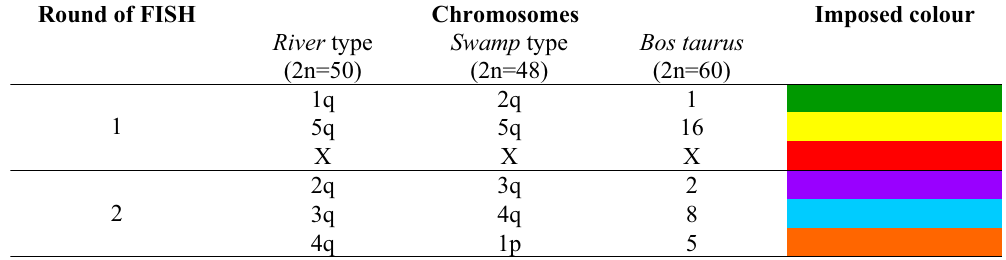
Table 2. Chromosome specific painting probes used in the sequential M-FISH for the river and swamp buffalo. Super imposed colours and homologous chromosomes in Bos taurus